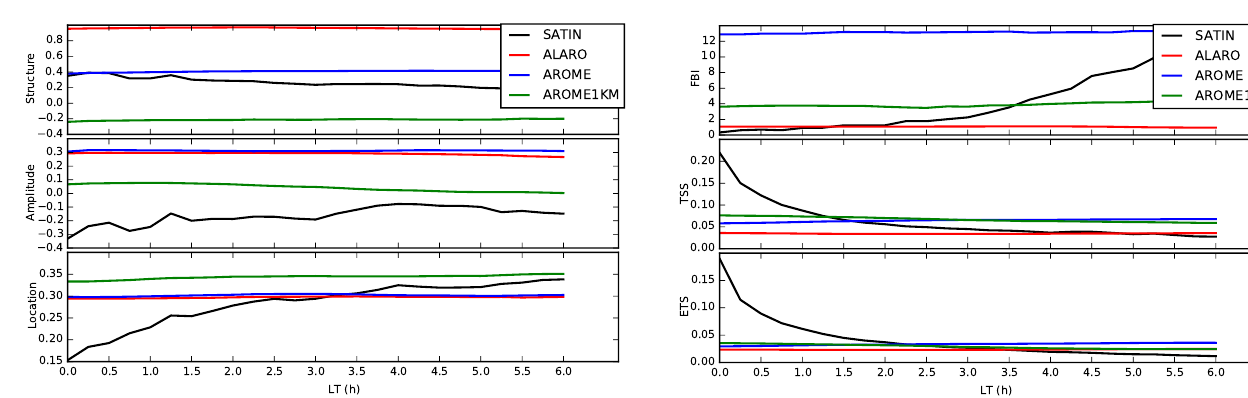
Figure 8. Comparison of pure (translational) nowcasting with NWP models: Structure, Amplitude, Location versus lead time, averaged over five days with heavy precipitation.